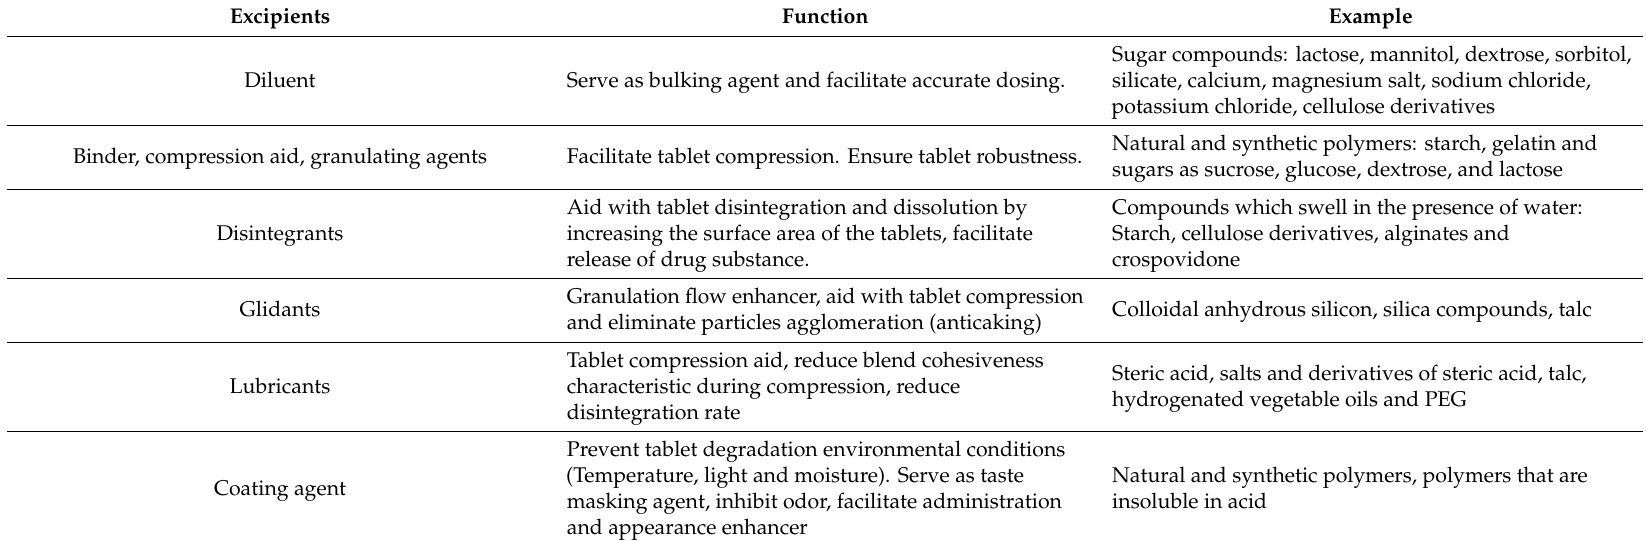
Table 2. Excipients used for tablet